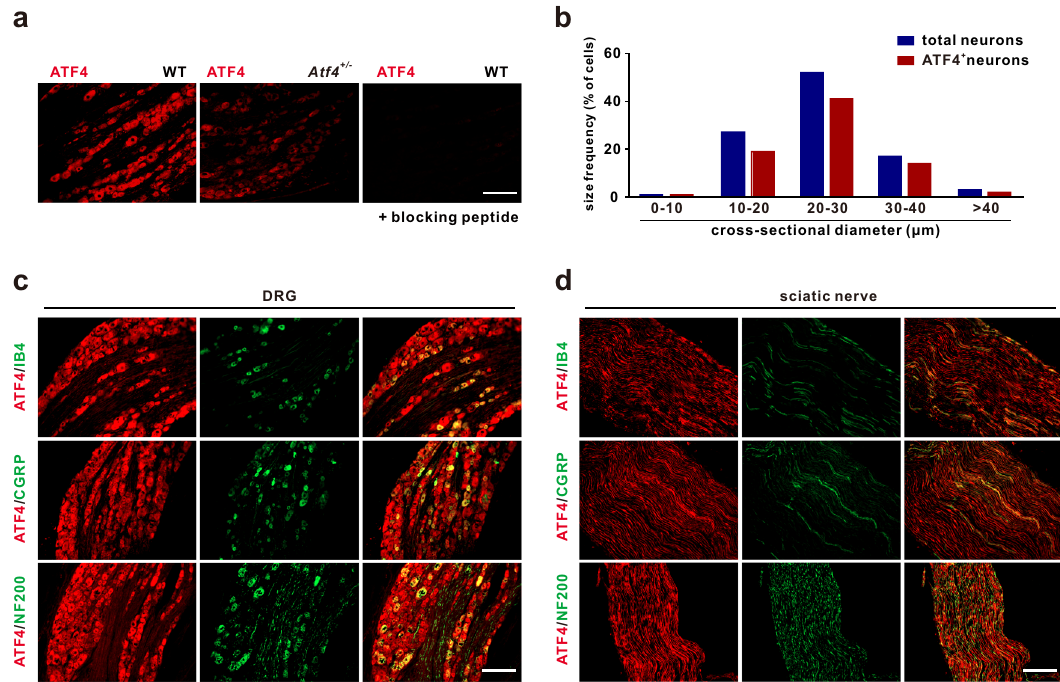
Fig. 1 Distribution of ATF4 in primary sensory neurons. a Left, image of immunostaining showing broad ATF4 expression in mouse DRG neurons. Middle, ATF4 expression was decreased in Atf4 + / − mice. Right, absence of ATF4 immunostaining upon treatment with a blocking peptide. Scale bar, 200 μ m. b Size frequency distribution of ATF4-positive and total neurons in the mouse DRG. A total of 1489 neurons from n = 4 mice were analysed. c , d Colocalization of ATF4 and cell markers (IB4, CGRP and NF200) in the DRG ( c ) and sciatic nerve ( d ). Scale bar, 200 μ